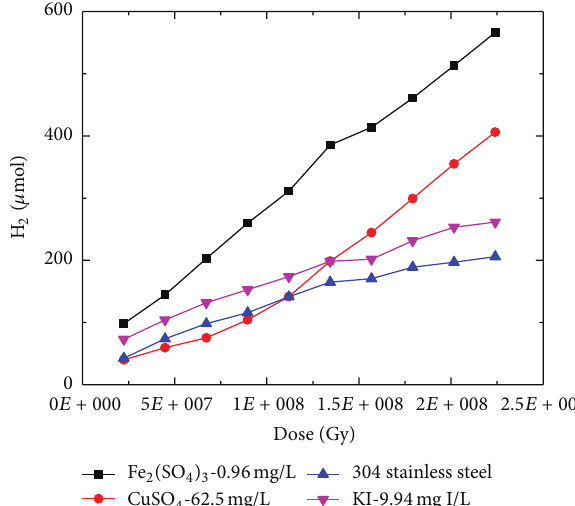
Figure 9: Oxygen evolution measured during irradiation of 126g- U/L UO 2 SO 4 solutions in the presence of potential peroxide cata- lysts at the Van de Graaff.